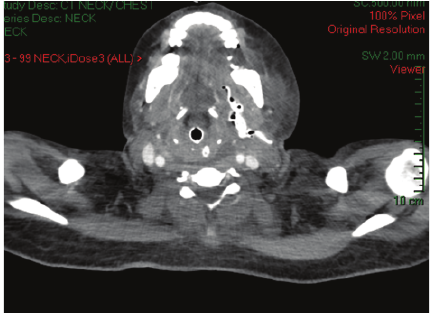
Figure 1: Neck abscesses.